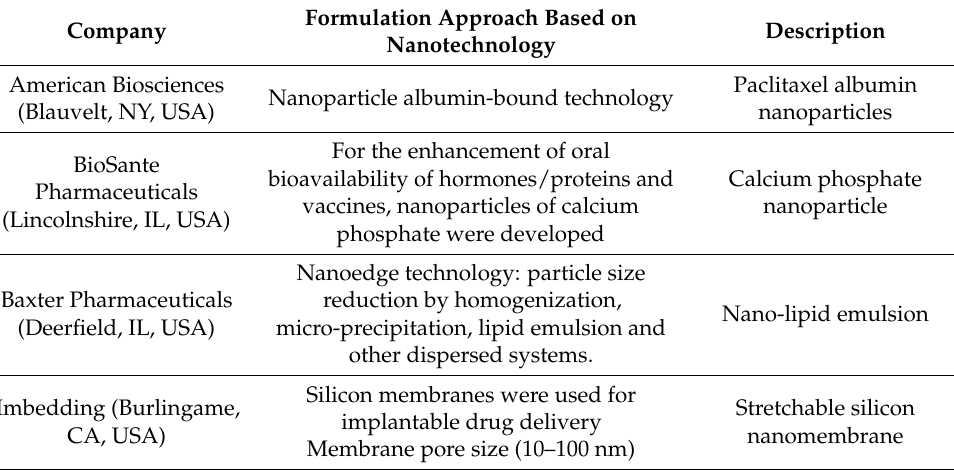
Table 5. Approaches for the enhancement of drug solubility and oral bioavailability by nanotechnol- ogy